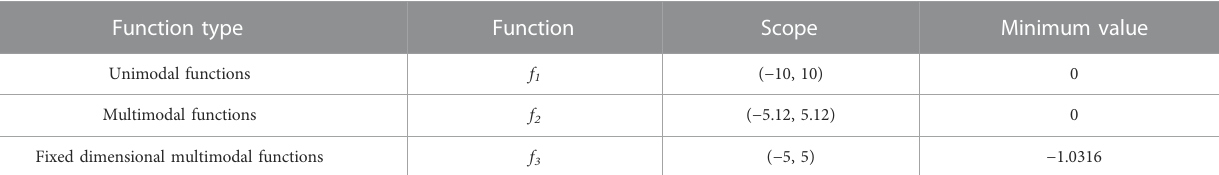
TABLE 1 Test functions and their related parameters.